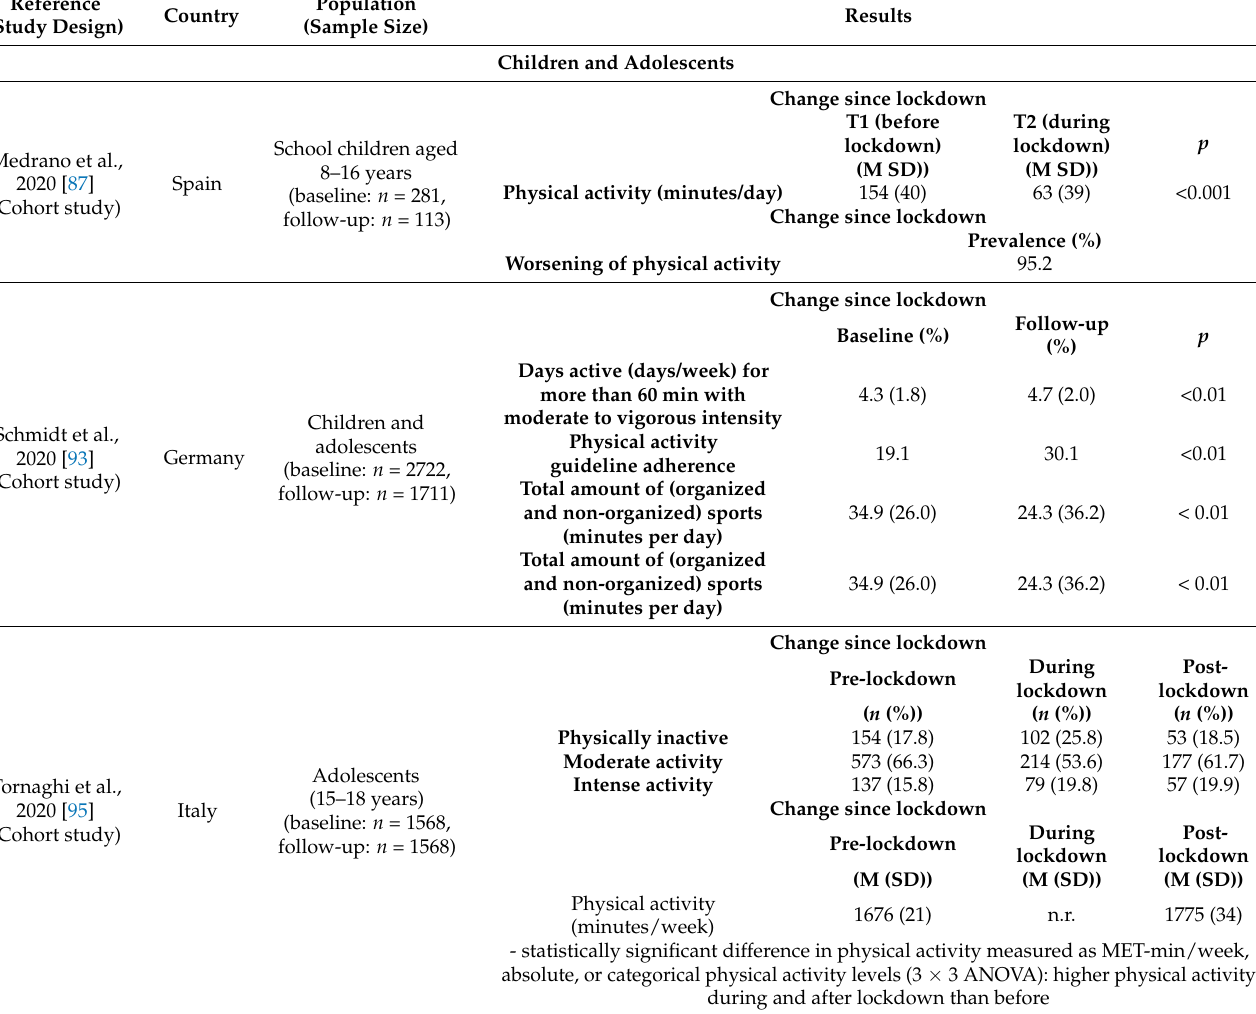
Table 4. Results on physical activity. * adjusted for year, age group, gender, ethnicity, period and period × age group interaction, ** adjusted for year, age group, gender, ethnicity, period and period × gender